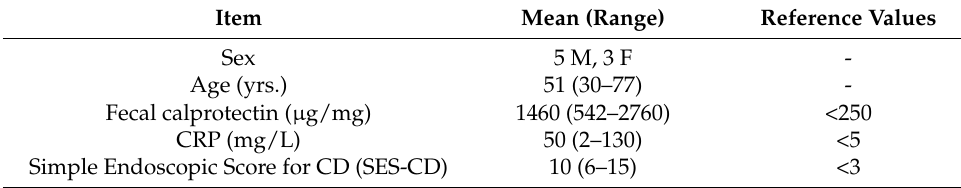
Table 1. Clinical